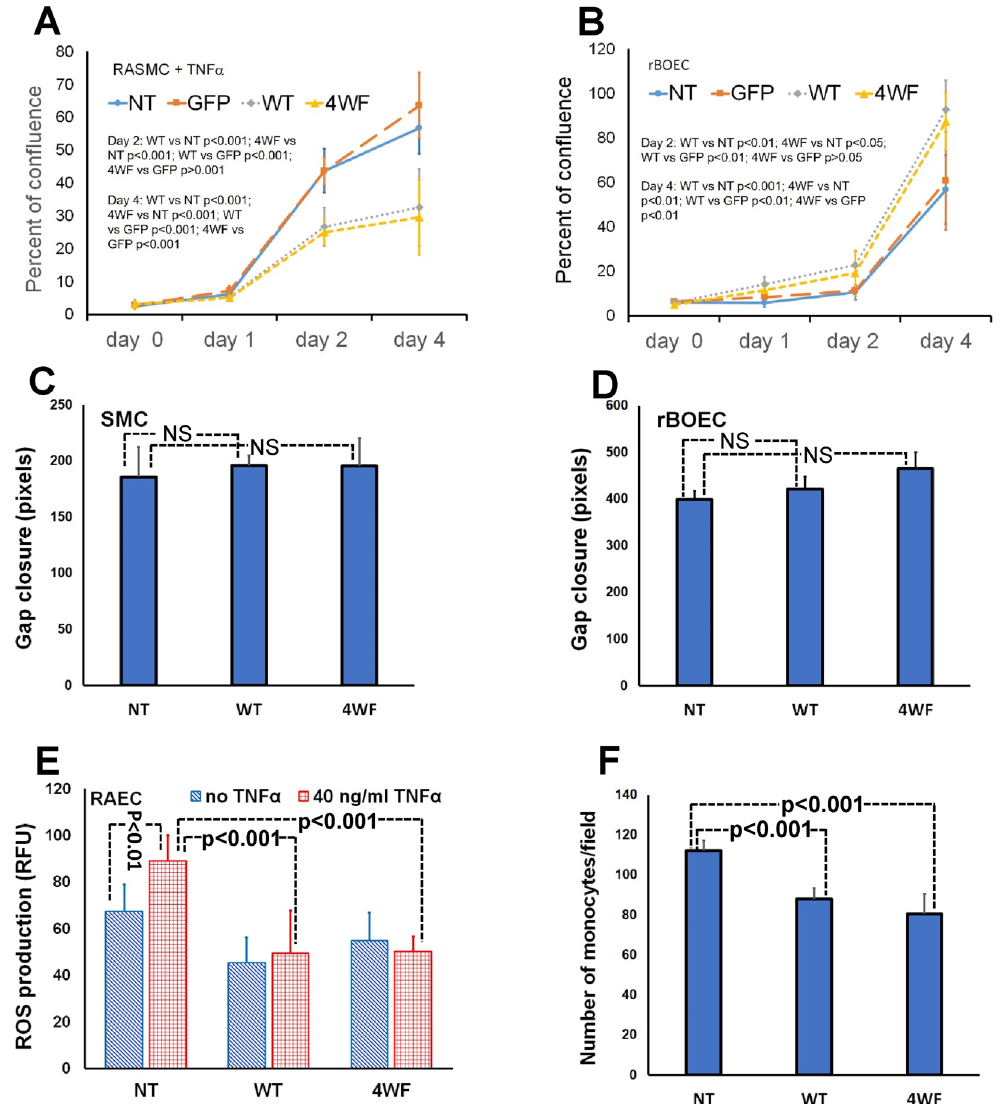
Figure 3. Impact of AAV2-apoA1(WT) and AAV2-apoA1(4WF) transduction on the proliferation and migration of SMC and BOEC, reactive oxygen species (ROS) production, and anti-inflammatory responses in endothelial cells. WST-8 assay was used to evaluate the effect of apoA1(WT) and apoA1(4WF) overexpression on proliferation of ( A ) TNFα (20 ng/ml)-stimulated rat aortic SMC and ( B ) non-stimulated rat BOEC. The results (both A and B ) were normalized by WST-8 assay values produced in confluent cultures of rat SMC ( A ) and rat BOEC ( B ) and expressed as the percent of a monolayer confluency. A monolayer scratch injury assay was used to assess migratory capacity of apoA1(WT)- and apoA1(4WF)-transduced rat SMC ( C ) and rat BOEC ( D ) compared with non-transduced counterparts. A closure of the gap inflicted by pipette tip was quantified 24 h after the scratch injury. ( E ) CM-H2DCFDA assay in non-transduced, apoA1(WT)- and apoA1(4WF)- transduced RAEC with/without TNFα stimulation. ( F ) Attachment of PKH26-labeled rat monocytes to TNFα- stimulated